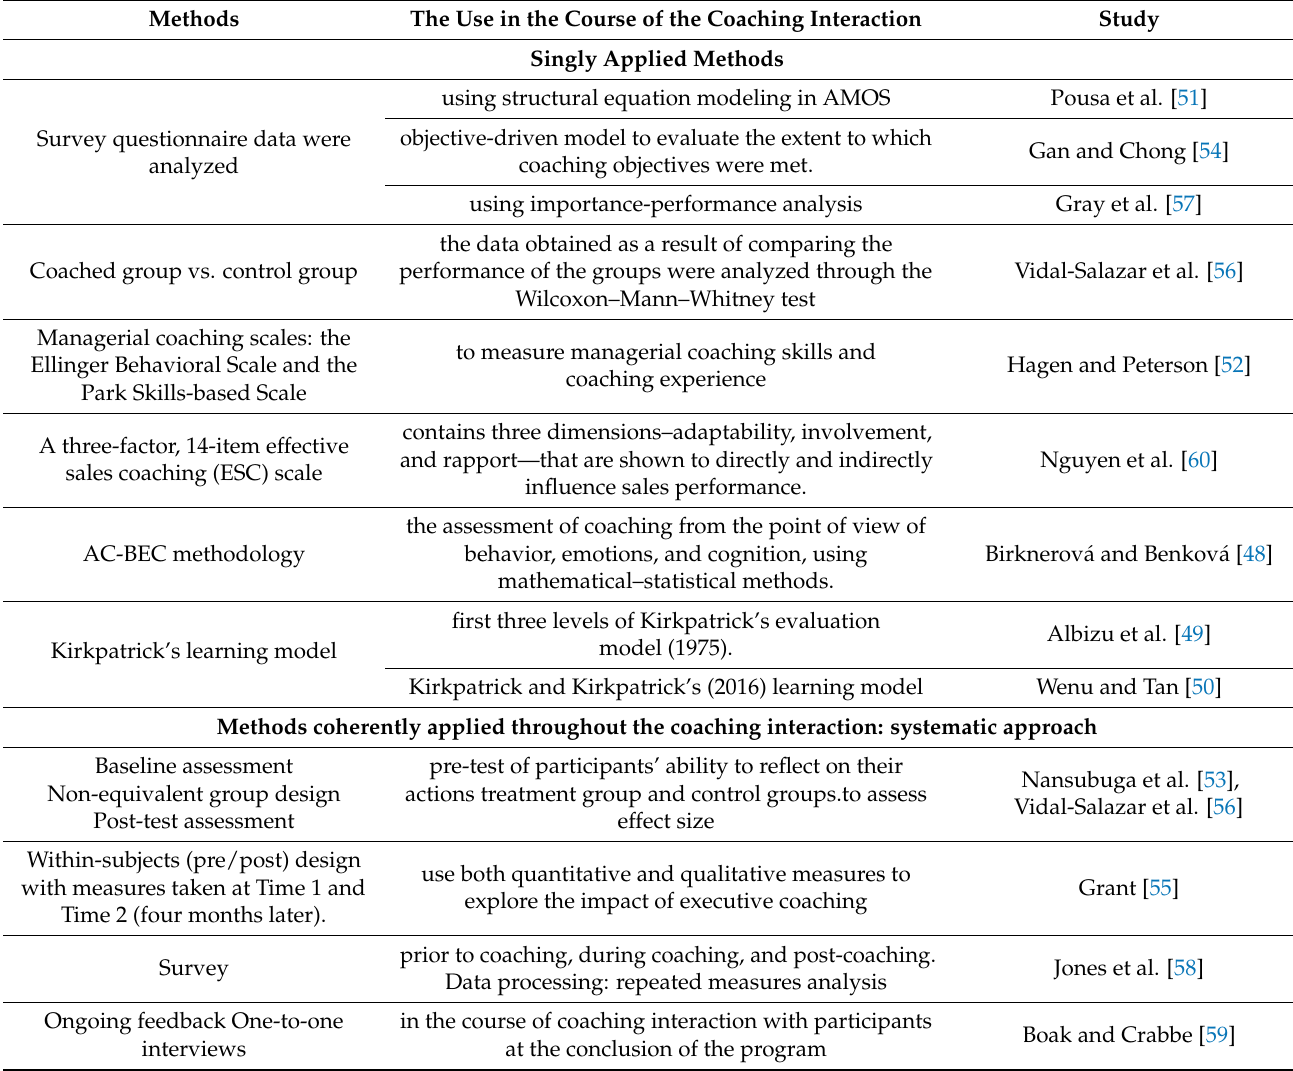
Table 3. The framework of the methods for assessing the impact of